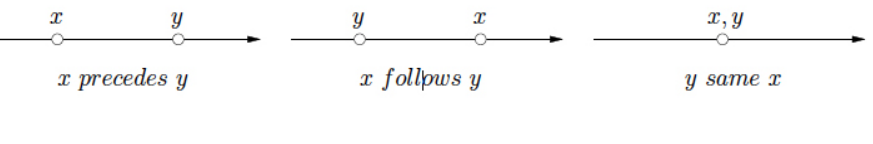
Figure 17. Time points algebra atomic relations